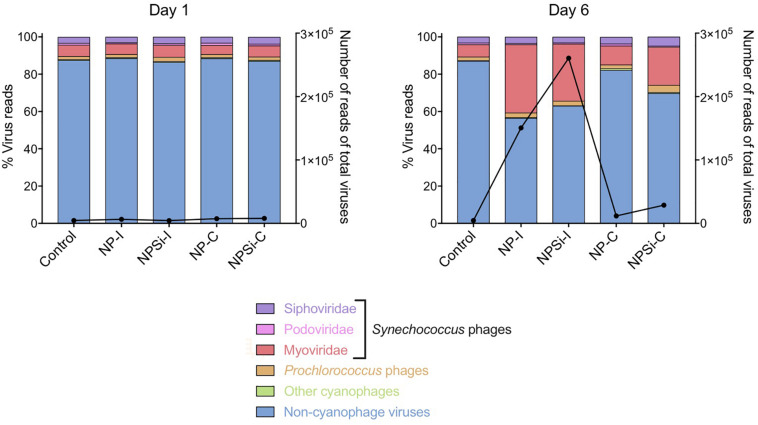
Changes in the relative proportions of reads assigned to Synechococcus phages and other viruses on days 1 and 6 under each treatment. Viral reads assigned to cyanophages, but with primary host unidentified to genus level are represented as “Other cyanophages.” The black line represents the number of reads of all virus present.